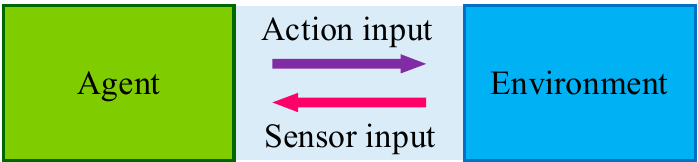
Figure 2. General relationship between an agent and environment.